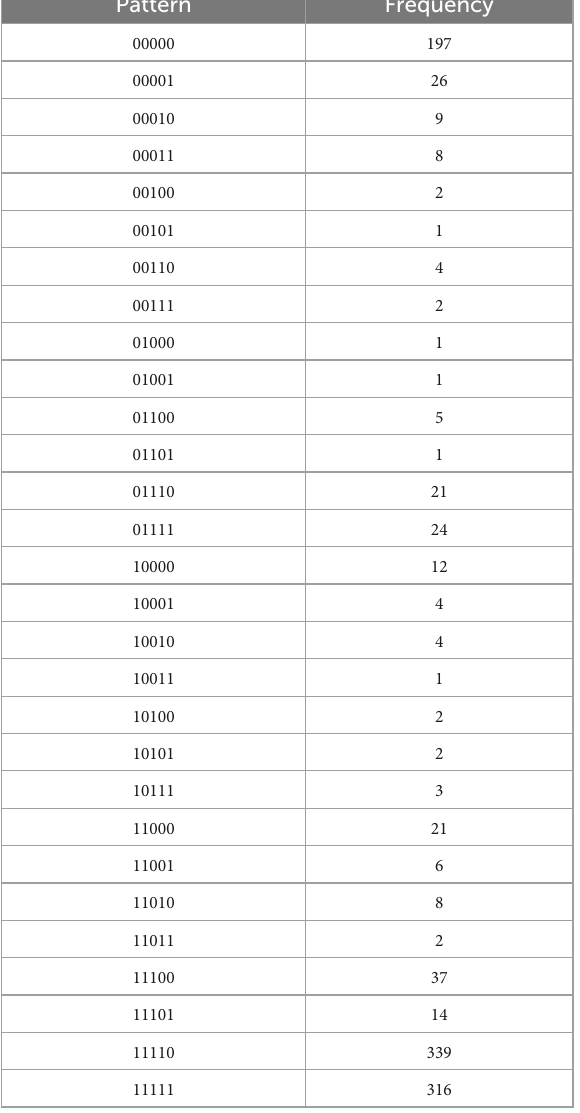
TABLE 4C Identified regulation, with N = 1073, k = 5 items, and u = 29 unique response patterns ( Appendix B ). Pattern